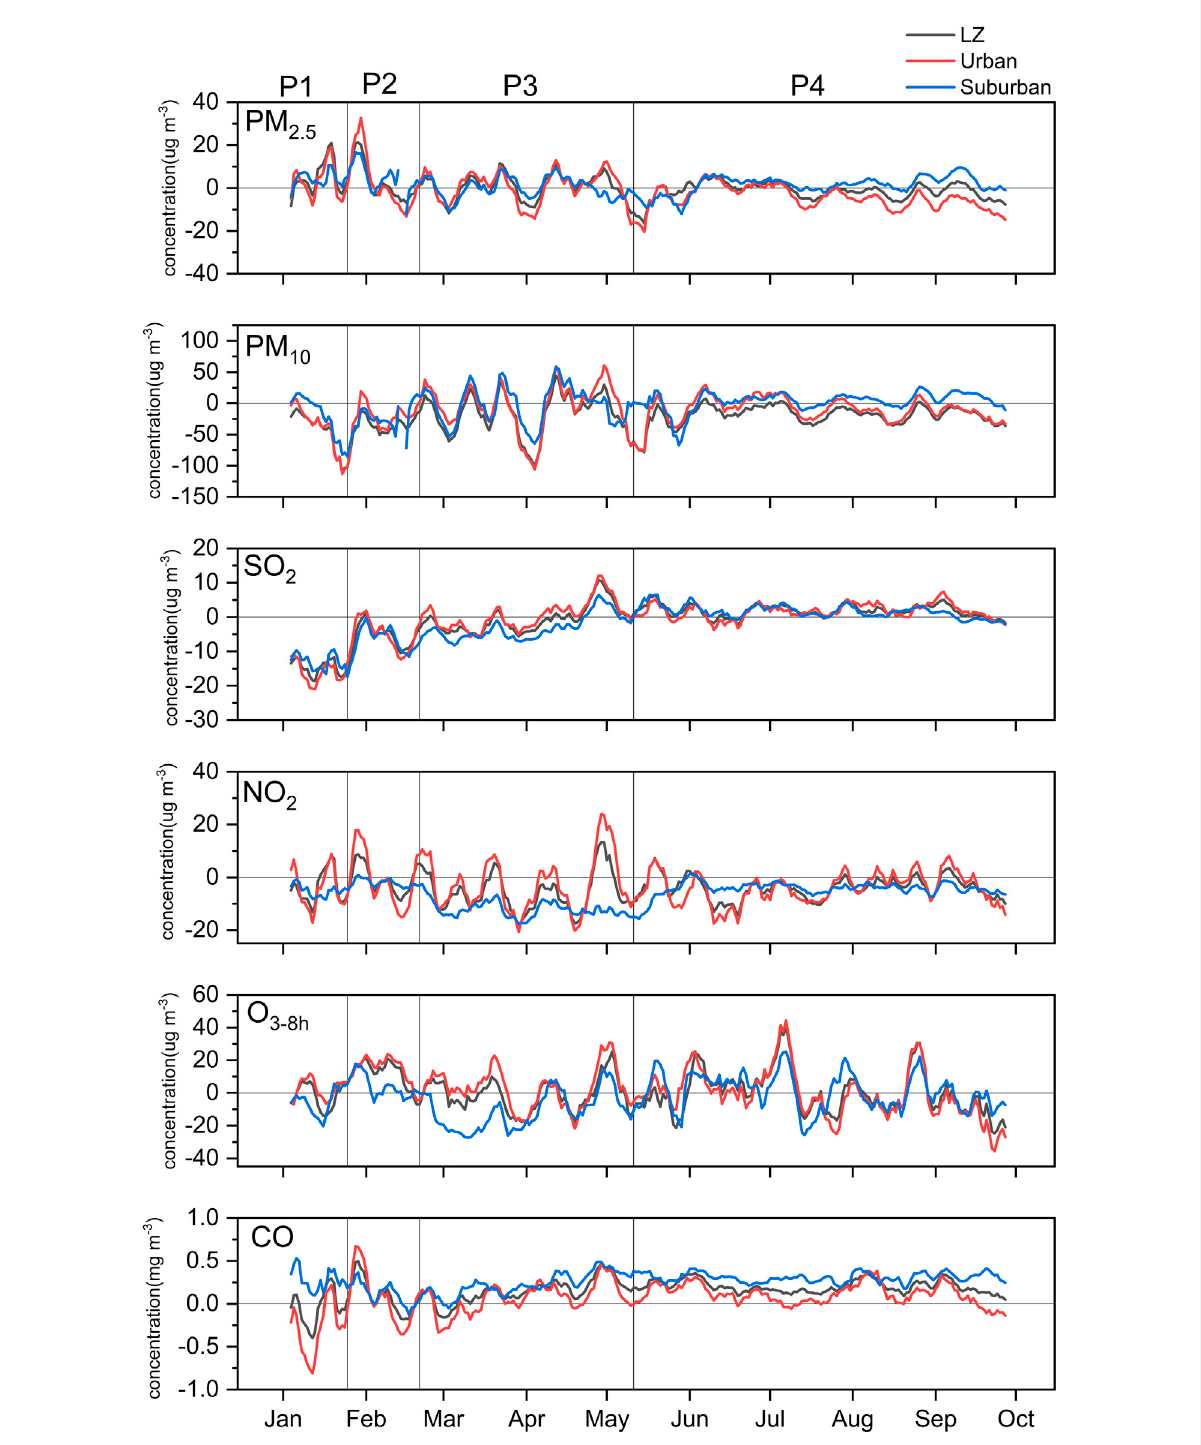
Changes in 7-day moving average residualsof six pollutants for all, urban and ruralsitesin 2020. P1, pre-lockdown; P2, Level Ⅰ response period; P3, Level Ⅲ response period; P4, relaxation